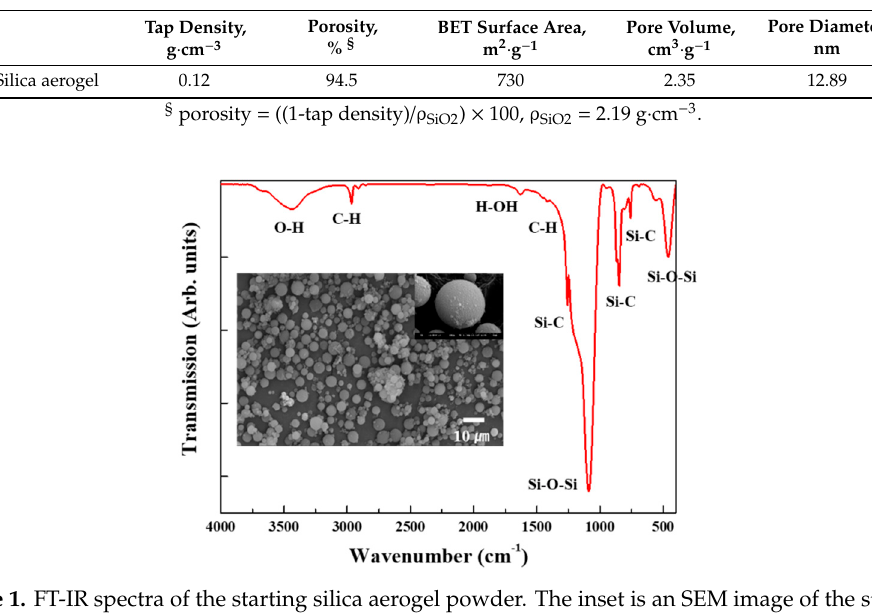
Table 1. Some physical properties of the starting silica aerogel powder.